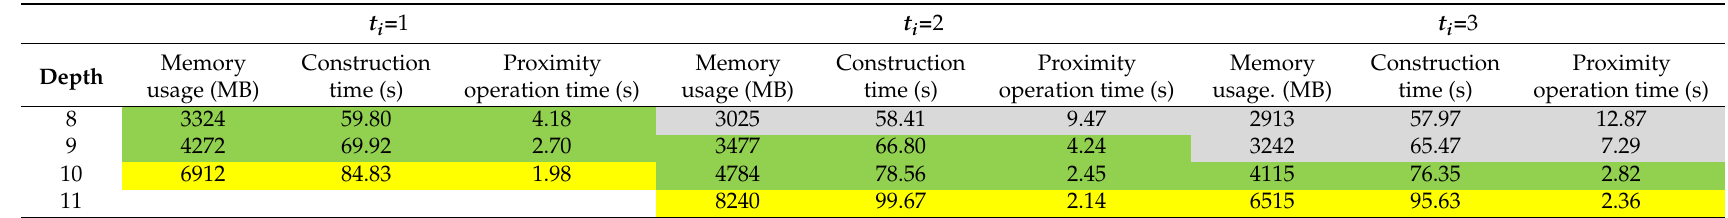
Table 10. Performance comparison among isometric octree groups using Data 1.